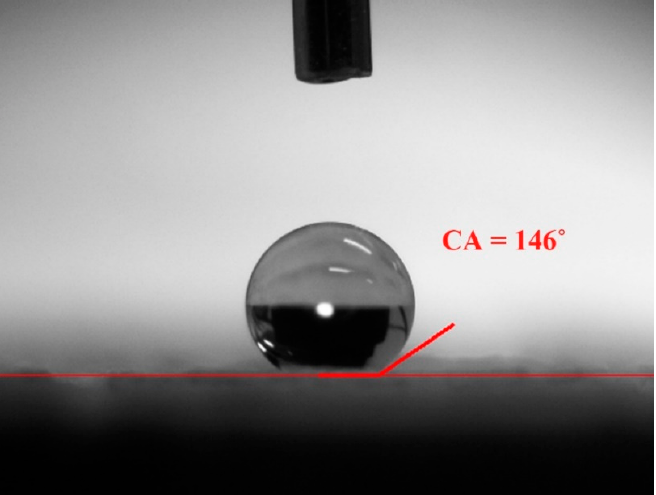
Figure 7. Contact angle test of the hydrophobic surface.